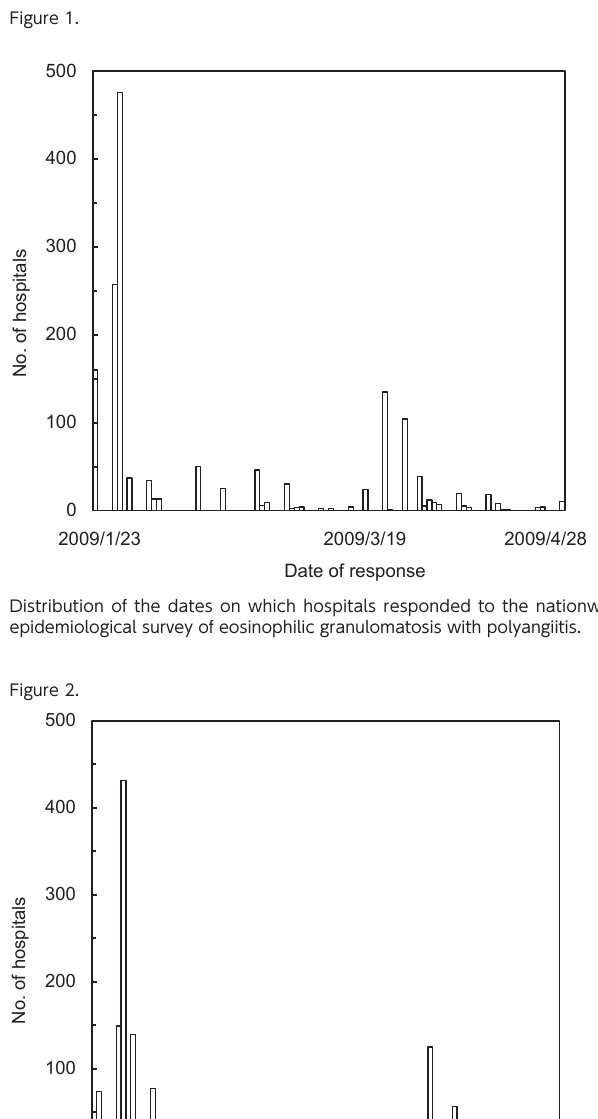
Figure Figure 1.